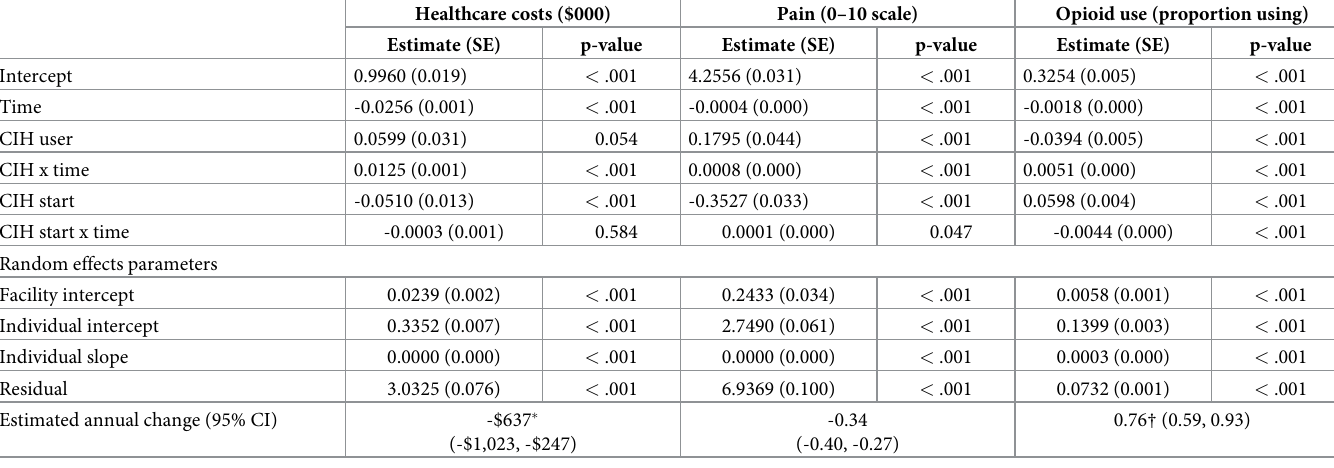
Table 2. Results of the hierarchical linear models (HLM) for each outcome over the 2-year study period.